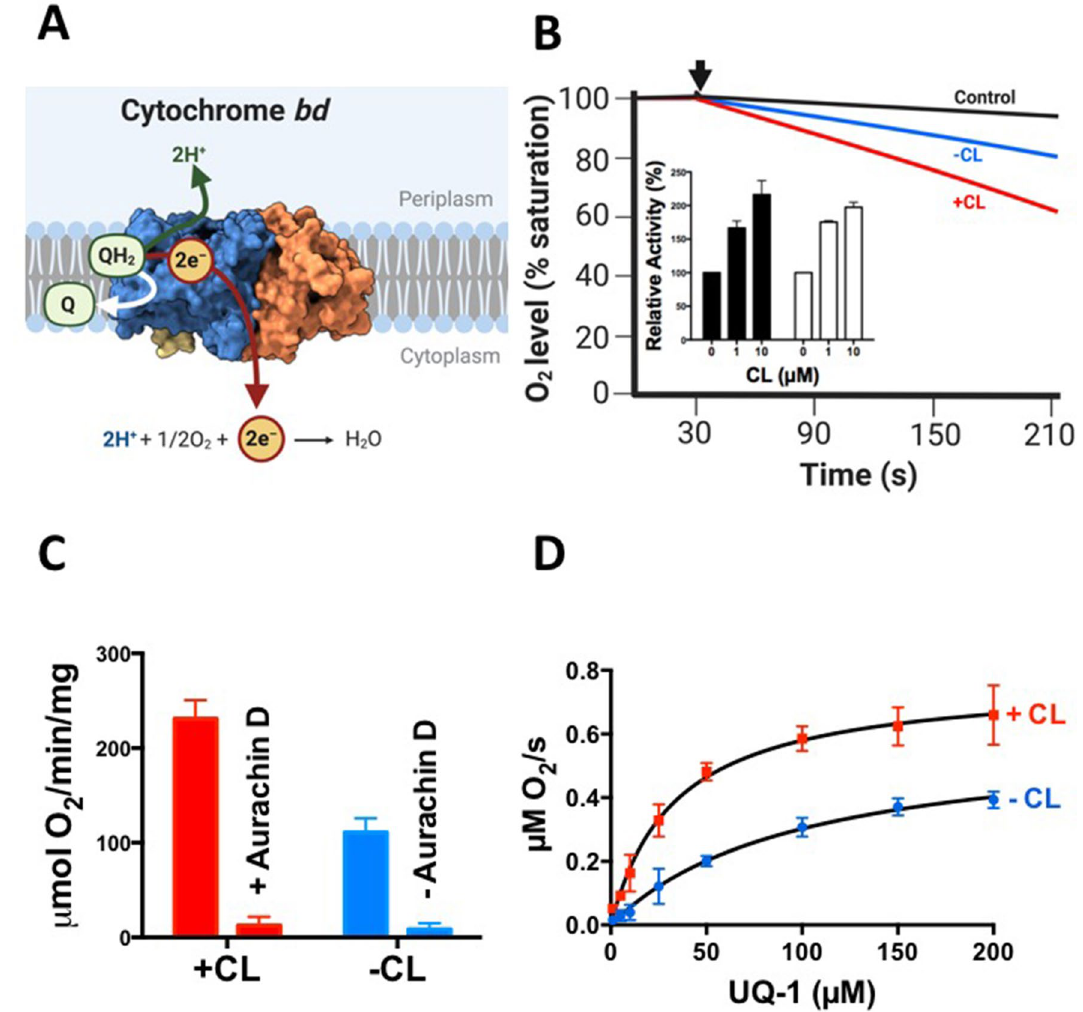
Figure 1. Activation of E. coli cytochrome bd by CL. ( A ) Enzymatic function of cytochrome bd (PDB ID: 6RKO 42 , figure created with BioRender 52 ). ( B ) The effect of CL (10 μM) on oxygen consumption activity by cytochrome bd (final conc. 2 nM) purified from E. coli was determined using a Clark-type electrode. The reaction was initiated by addition of ubiquinone-1 + DTT (arrow), the negative control contained ubiquinone-1 and DTT, but no cytochrome bd . Inset: Dependency of activation on the pre-incubation time at the indicated CL concentrations. The enzyme was incubated with CL prior to starting the reaction for either 3 min (black bars) or 60 min (white bars). ( C ) Impact of the inhibitor aurachin D (400 nM) on oxygen consumption by cytochrome bd in the presence or absence of 10 µM CL. ( D ) Effect of CL on the K M value of E. coli cytochrome bd . Curve fit was done with a simple Michaelis–Menten analysis; R 2 values in the absence and presence of CL were 0.978 and 0.969, respectively. Average values were calculated from at least two biological replicates at 37 °C; error bars represent standard